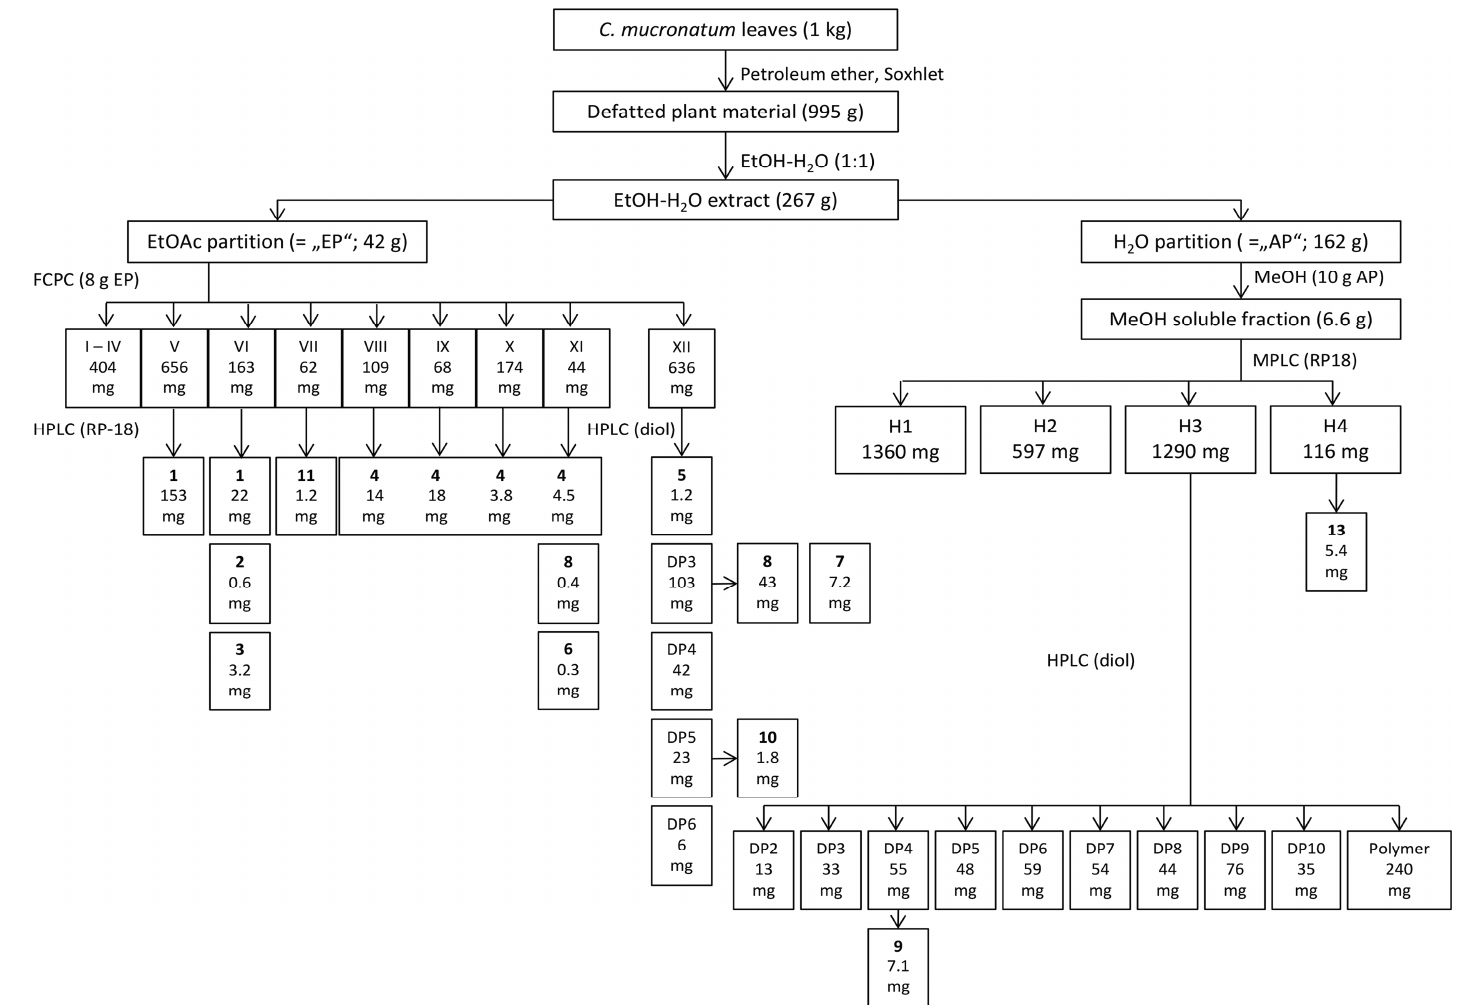
Figure 1. Extraction and fractionation scheme of leaves from Combretum mucronatum as described in the materials parts 3.3 to 3.5 of this